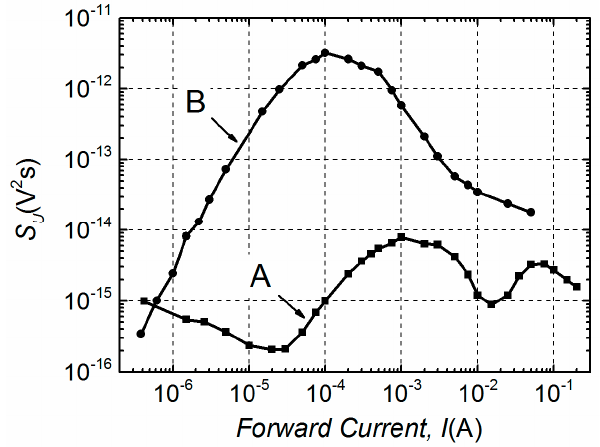
Figure 4. The experimental voltage fluctuation spectral density ( S U ) dependencies on the forward current at 1 kHz frequency characteristic for group A and B LDs at room temperature.